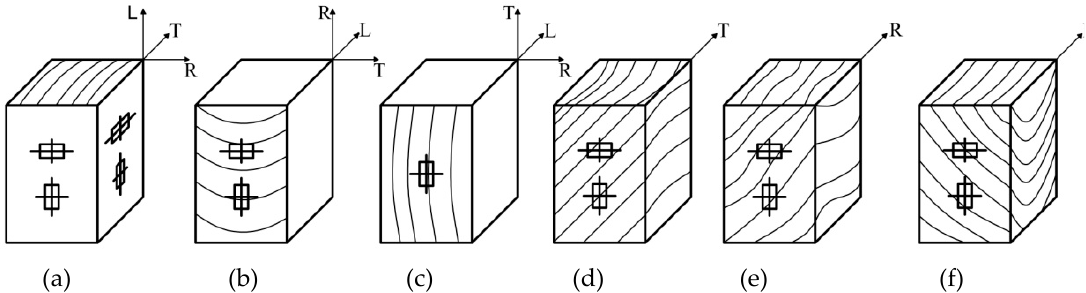
Figure 2. Configurations of specimens used to determine the elastic constants of beech ( a ): E L , µ LR and μ LT ; ( b ): E R and μ RT ; ( c ): E T ; ( d ): G LR ; ( e ): G LT ; ( f ): G RT . Table 1. Configurations of specimens used to measure elastic mechanical properties of beech.